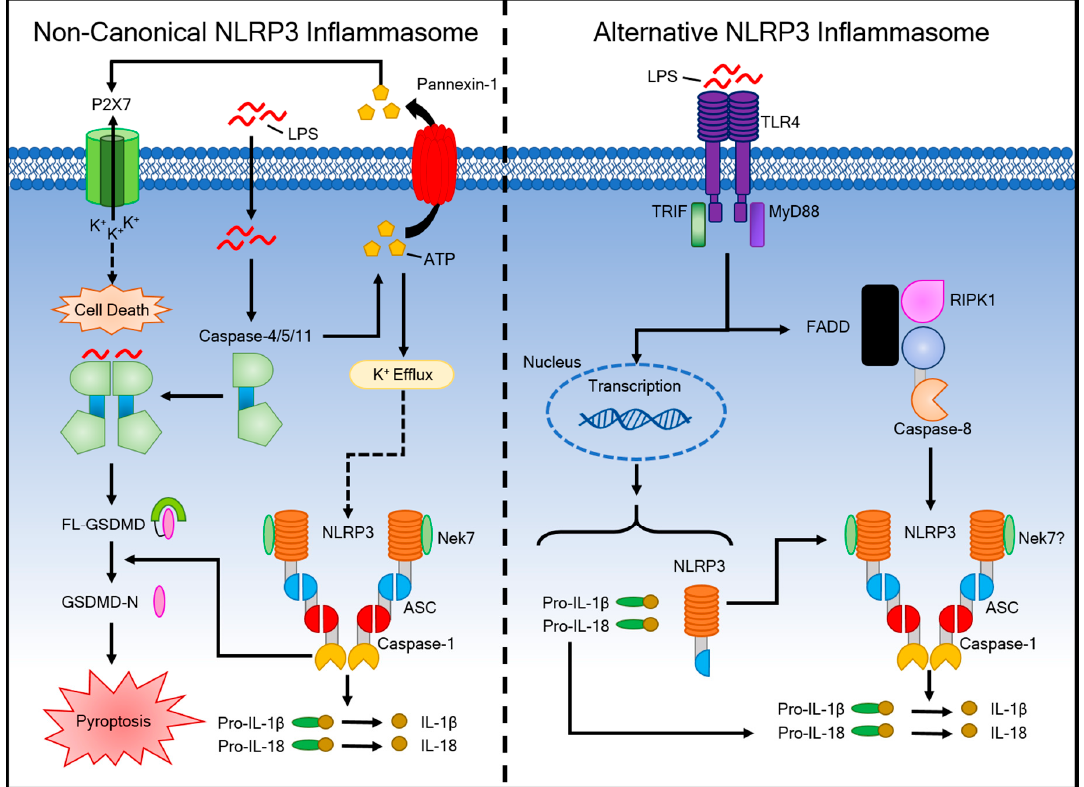
Figure 2. Mechanism of Activation for the Non-Canonical and Alternative NLRP3 Inflammasome Pathways. Non-canonical NLRP3 inflammasome activation ( left ) is induced by LPS internalization into the cytosol by transfection or infection. Caspase-11 / 4 / 5 induces pyroptosis through the cleavage of GSDMD. This process also activates pannexin-1 through caspase-11 to release ATP and induce K + efflux, which drives NLRP3 inflammasome assembly and release of IL-1 β . The alternative NLRP3 inflammasome ( right ) is activated in human monocytes in response to LPS and requires receptor-interacting serine / threonine-protein kinase 1 (RIPK1), FADD, and caspase-8 for its activation. This pathway is K + efflux independent and does not induce pyroptosis.